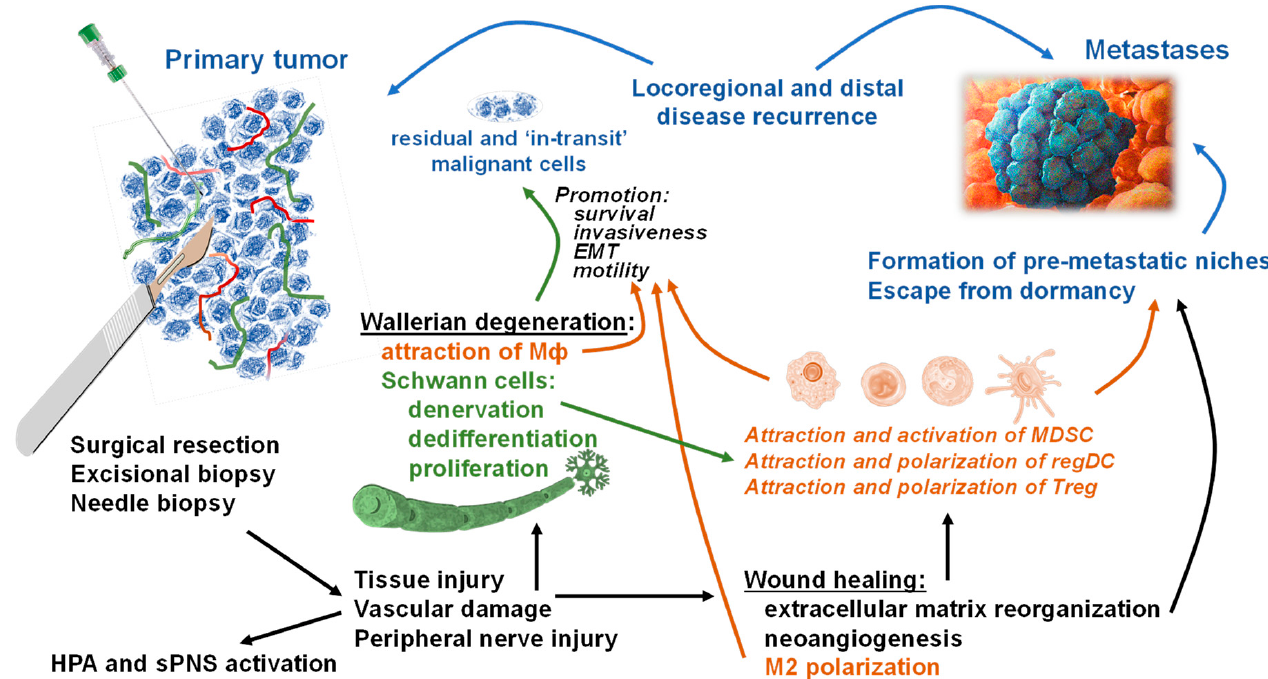
Figure 1. Pathways and mechanisms of accelerated locoregional and distant tumor recurrence after surgical interventions on primary tumors. Resection and biopsy cause unavoidable tissue distraction, damage of blood and lymph vasculature, and injury and trauma of the peripheral neurons. Central systemic effects of surgical stress, together with its psychological components, result in the hypothalamic ‐ pituitary ‐ adrenal (HPA) axis activation and stimulation of the sympathetic branch of the peripheral nervous system (sPNS). Locally, tissue injury and regional hemorrhage, followed by different levels of hypoxemic cellular stress, inflammation, and ischemia, initiate a cascade of tissue repair pathways including wound heal ‐ ing and Wallerian degeneration. The wound healing, after the initial hemostasis and inflammation phases, incorporates extracellular matrix reorganization for remaking new tissue, neoangiogenesis/lymphogenesis for a new network of blood/lymph vessels, and attraction and polarization of regulatory immune cells, such as macrophages (alternatively ac ‐ tivated type 2 or M2), for resolving inflammation and augmentation of tissue and vasculature restoration. These pathways phenotypically and functionally resemble the tumor microenvironment characteristics and thus may promote reactivation of dormant malignant cells, the formation of premetastatic niches and the survival and motility of residual and “in ‐ transit” cancerous cells. Wallerian degeneration, prompted by the axonal injury, involves Schwann cell activation–denervation, de ‐ differentiation, and proliferation (‘repair’ phenotype), which is required for the attraction of macrophages (M ф ), clean ‐ ing the myelin and dead neuronal debris, and axonal regeneration. Resent data revealed that the repair Schwann cells functionally resemble the tumor ‐ activated Schwann cells that can attract and activate myeloid ‐ derived suppressor cells (MDSC), attract conventional dendritic cells (DC) and polarize them into regulatory immunosuppressive DC (regDC), and attract and polarize T cells into the regulatory phenotype (Treg). This pathway also supports local and systemic tumor ‐ associated environments, which favor the establishment and growth of local and distant micrometastases. In addition, activated Schwann cells have been reported to induce the epithelial ‐ mesenchymal transition (EMT) of malignant cells suggesting that tumor pre ‐ activated, as well as axon injury ‐ activated, Schwann cells may boost motility and invasiveness of residual and “in ‐ transit” cancerous cells supporting the formation of the locoregional and distant metastases after sur ‐ gical excision of primary tumors. (Cancerous cells and their migratory pathways are shown in blue font and blue arrows; immune cells and their effects on malignant cells are shown in brown font and brown arrows; neuroglial Schwann cells and their effects on immune and malignant cells are shown in green font and green arrows. Common pathways connected